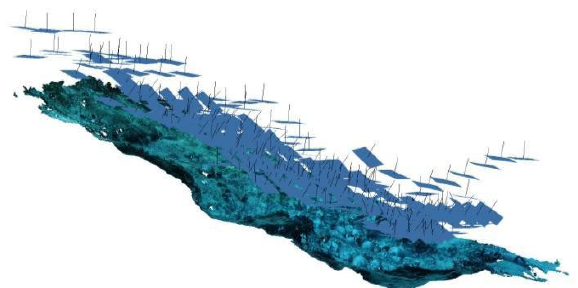
Figure 8. Disposition of the camera shooting.